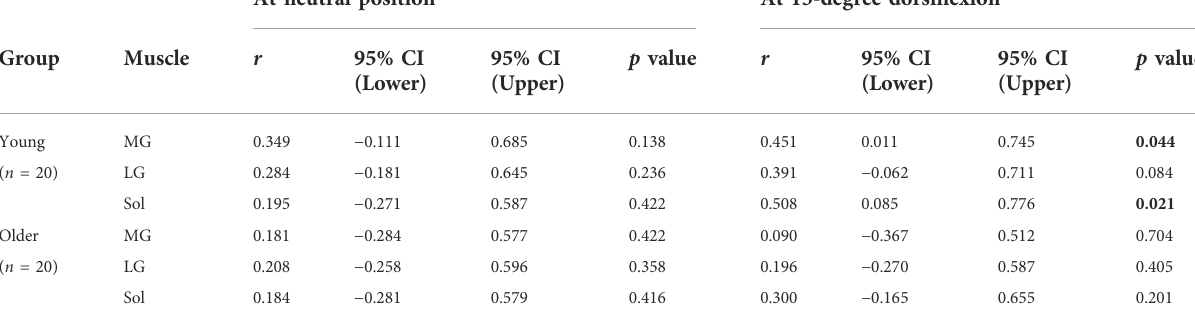
TABLE 3 Pearson correlation coef fi cients between the absolute ankle joint stiffness and muscle shear modulus of the triceps surae. At neutral position